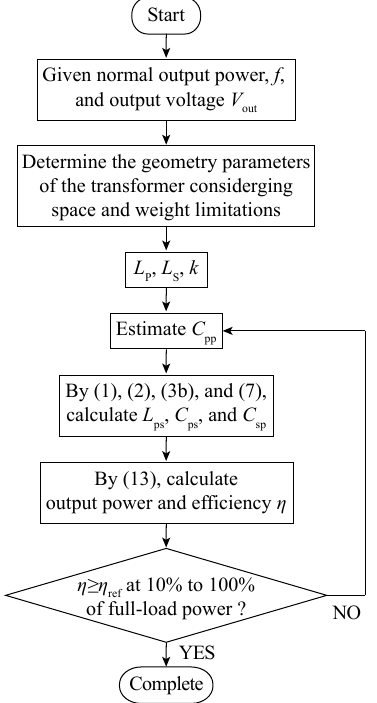
Figure 6. Design chart of the compensation components of the LCC-parallel